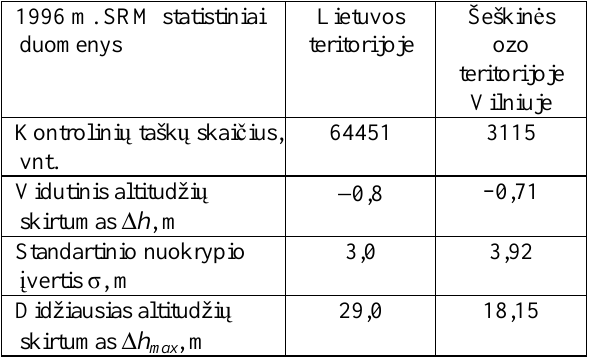
Table 3. Statistical parameters of DTM height differences